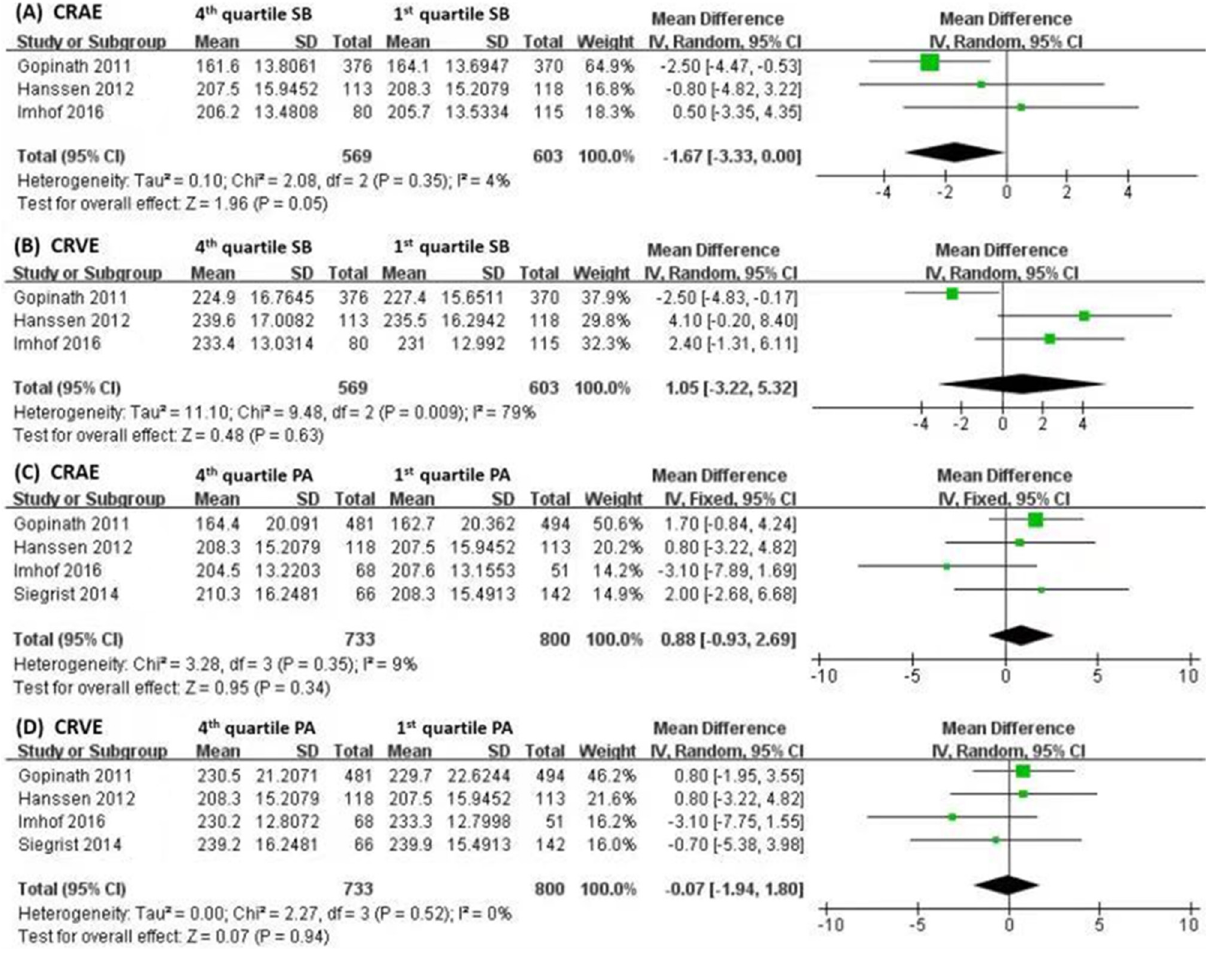
Figure 3. ( A , B ) The meta-analysis performed to assess the association between SB (1st and 4th quartiles) and changes in CRAE and CRVE. ( C , D ) The meta-analysis performed to assess the associations between PA (1st and 4th quartiles) and changes of CRAE and CRVE. CRAE: central retinal arteriolar equivalent; CRVE: central retinal venule equivalent; SB: sedentary behavior; PA: physical activity [6,11,13,20]. Table 2. Studies reported associations between PA/SB/Sleep and RVC.